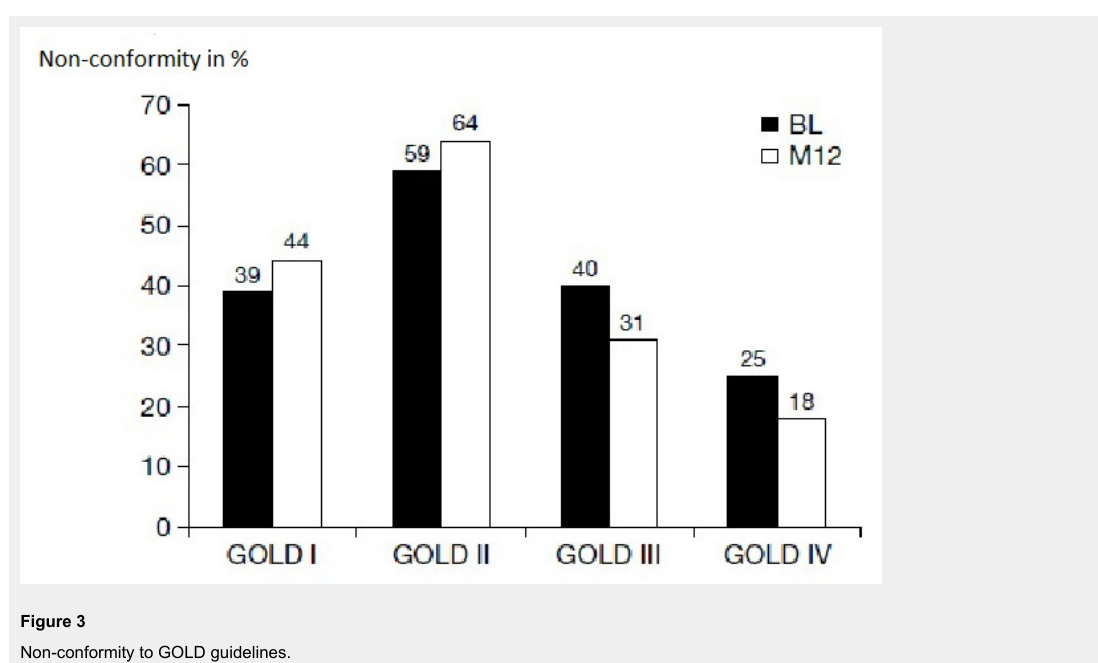
Figure 3 Non-conformity to GOLD guidelines. Comparison of guideline aberrant treated patients at BL and after 12 months. Abbreviations: GOLD, Global Initiative for Chronic Obstructive Lung Disease; BL, baseline; M12, month